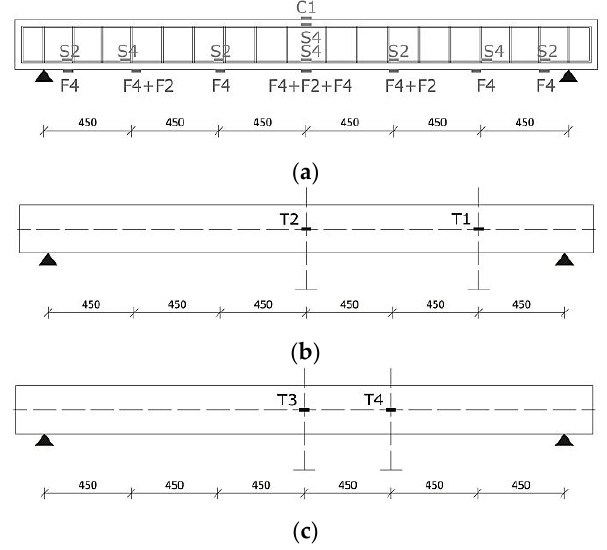
Figure 2. Instrumentation: ( a ) Internal and external strain gauges position along the strengthened beams; ( b ) Position of the Linear Variable Displacement Transducers (LVDTs) on the front face of the beams; ( c ) Position of the LVDTs on the back face of the beams. Fibers 2016 , 4 , 19